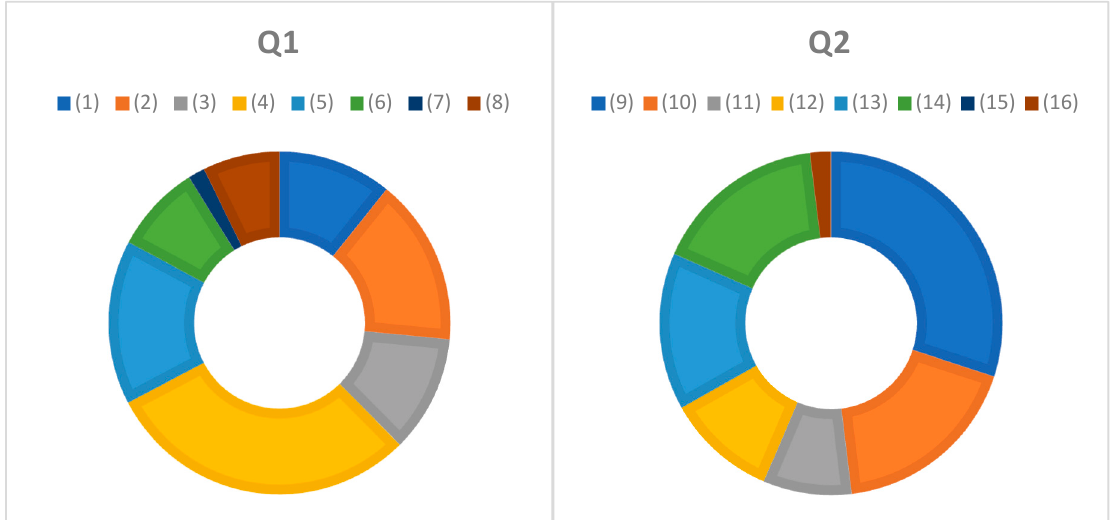
Figure 2- Main categories, statements per question, and percentage distribution of the statements